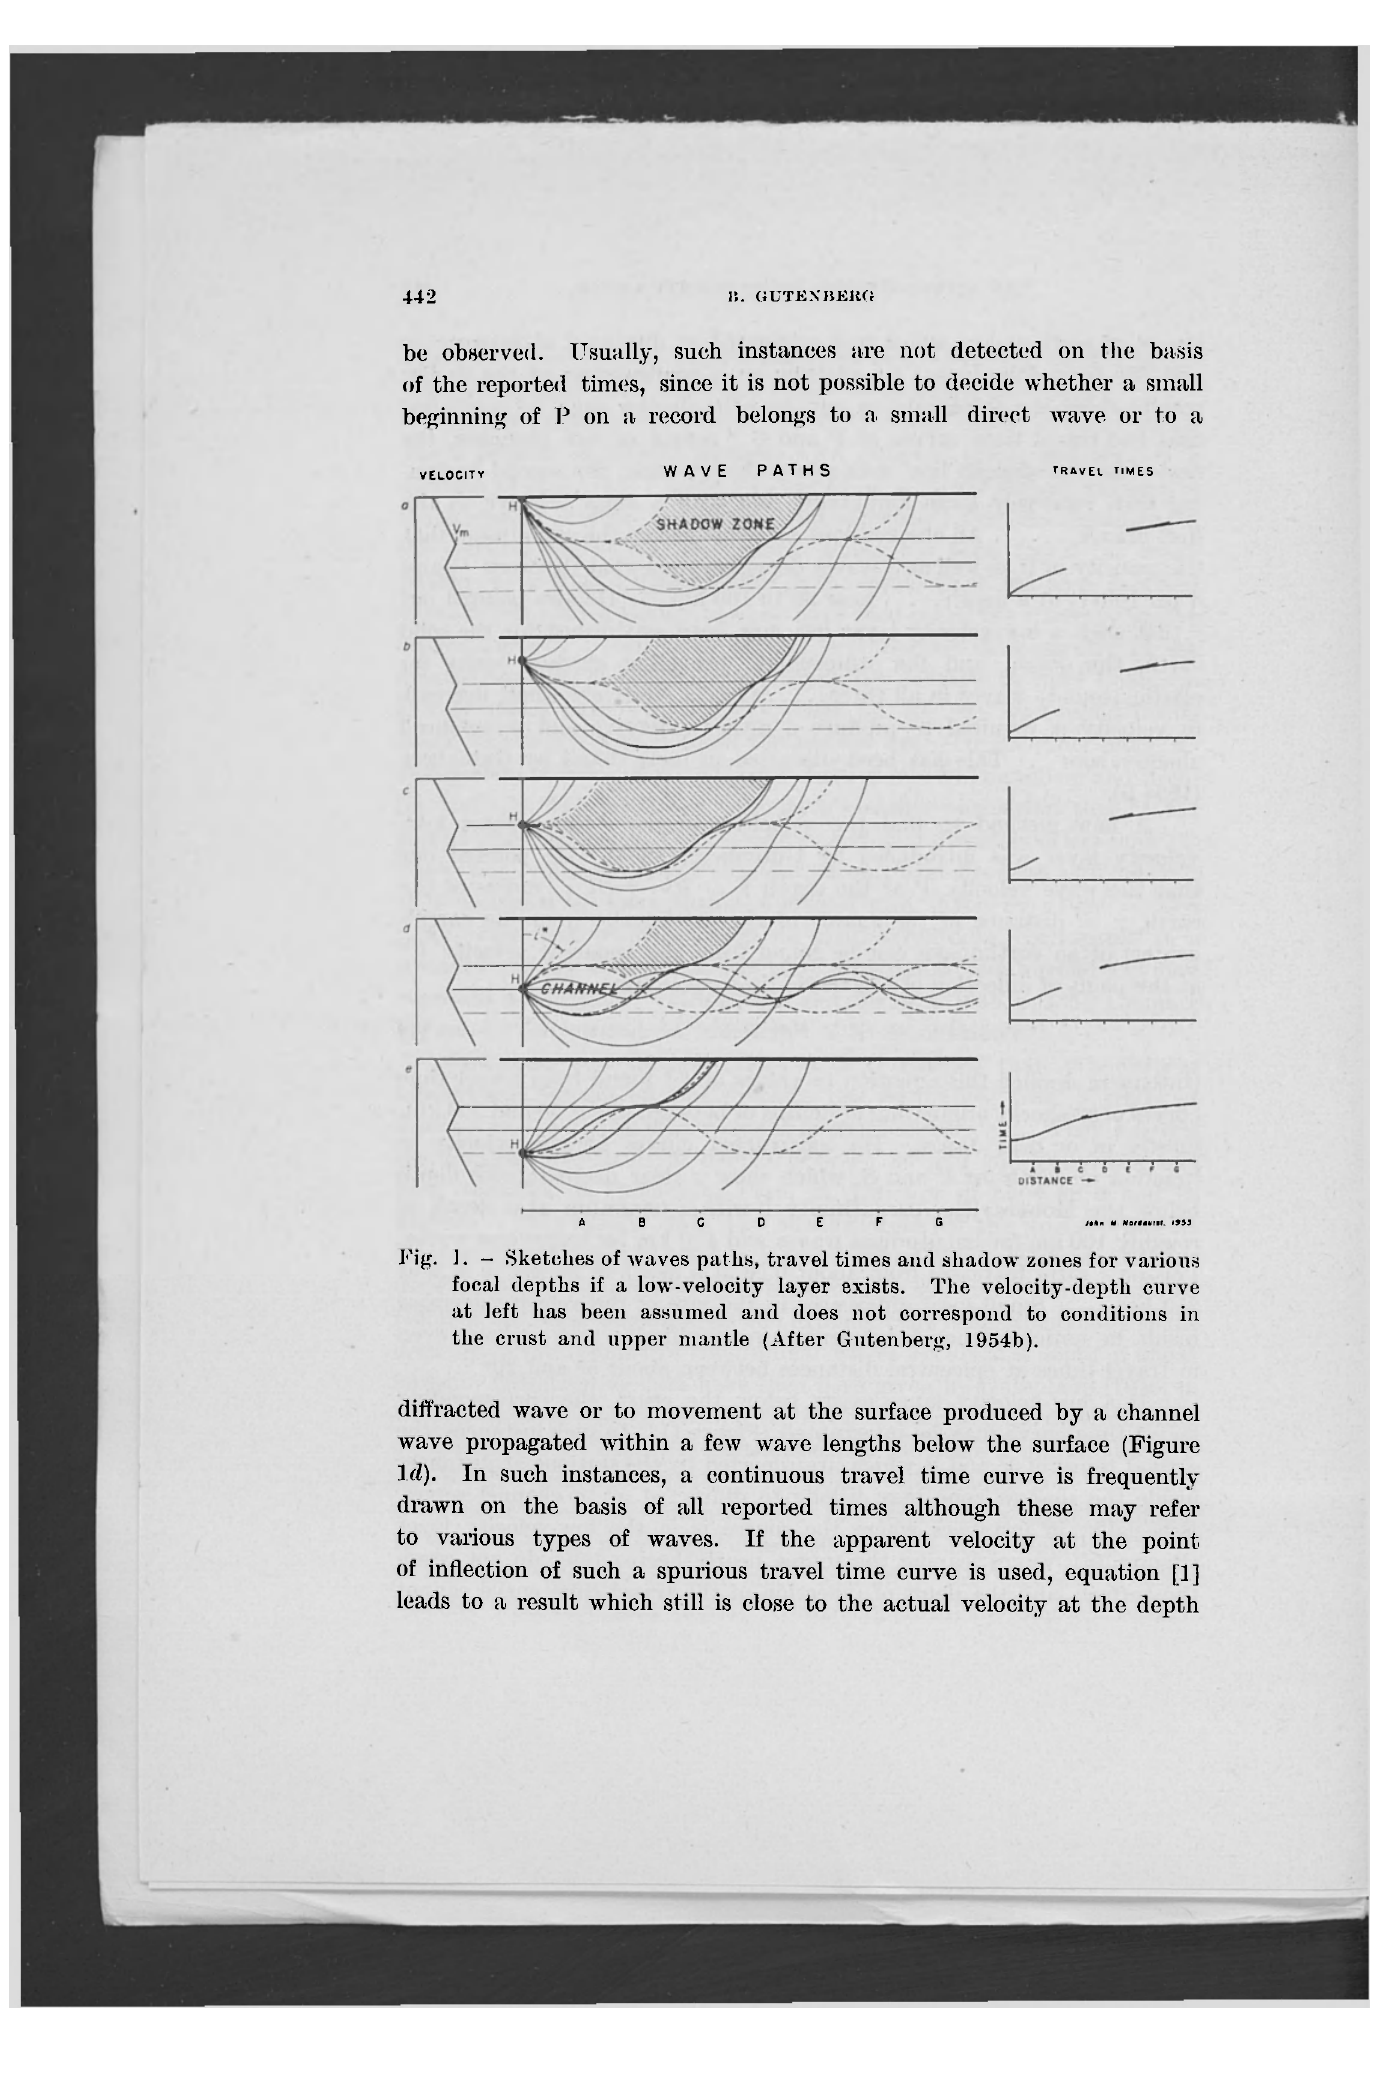
Fig. J. - Sketches of waves paths, travel times and shadow zones for various focal depths if a low-velocity layer exists. The velocity-depth